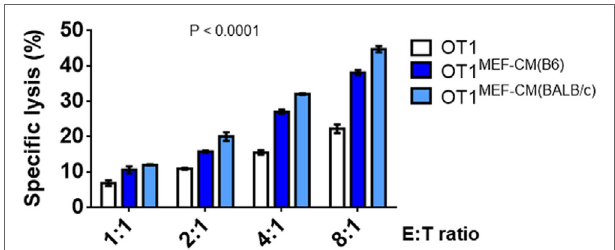
FigUre 4 | Specific lysis of EG.7 targets by effector OT-1 cytotoxic T lymphocytes (CTLs), effector OT-1 CD8 + T cells were prepared by the stimulation for 3 days in the presence or absence of mouse embryonic fibroblast-conditioned medium (MEF-CM) (50%, v/v). EG.7 cells which expression OVA was used as target cells. Effector cells and target cells were incubated 4–5 h in E:T ratios ranging from 1:1 to 8:1. To prevent